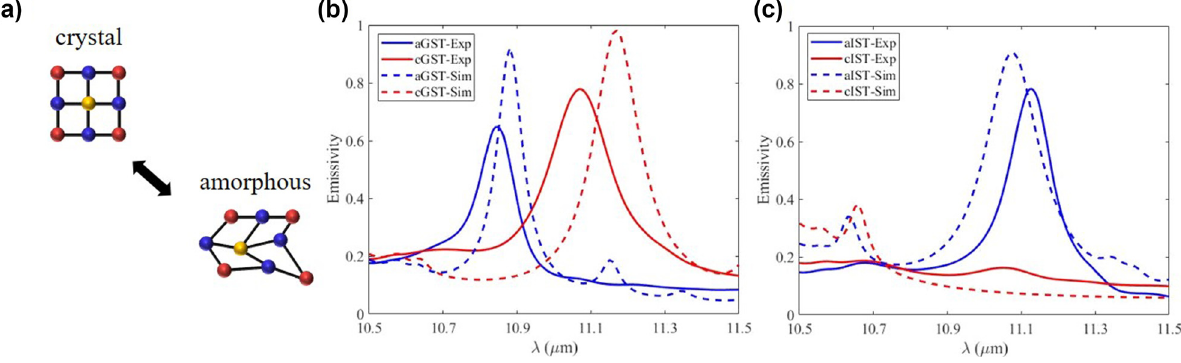
Figure4: Tunablethermalemissionwith phasechangematerials.(a) Schematic illustrationof the phasetransition. (b)The simulated (dotted curve) and experimental (solid curve) emission spectra of GST-SiC phonon-mediated nanostructure. (c) The simulated (dotted curve) and experimental (solid curve) emission spectra of IST-SiC phonon-mediated